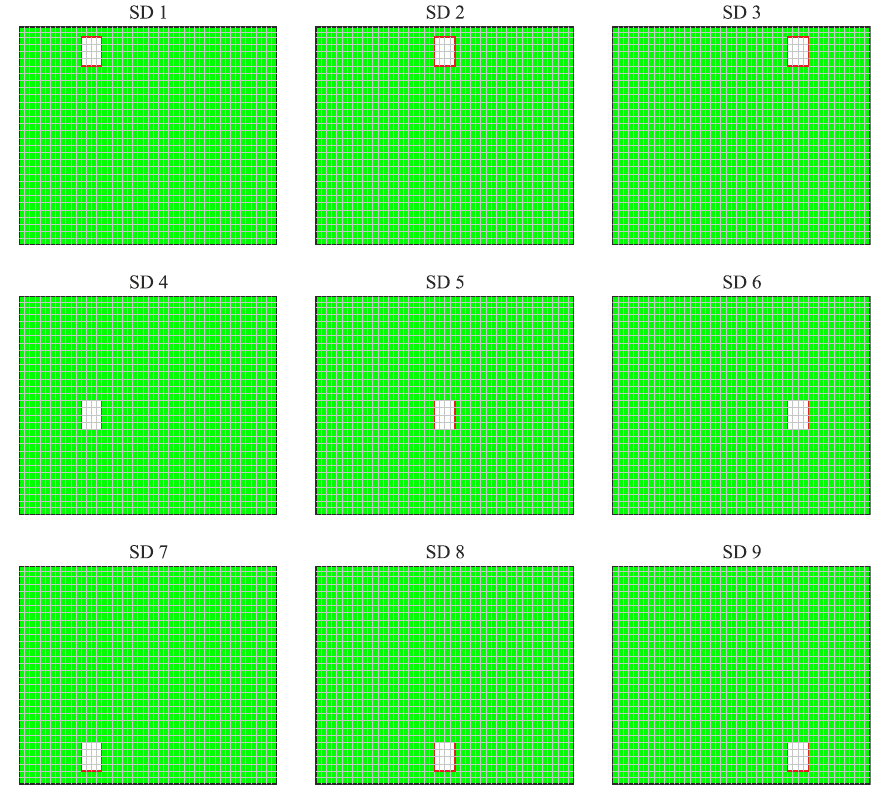
Fig. 8 9 single-damage